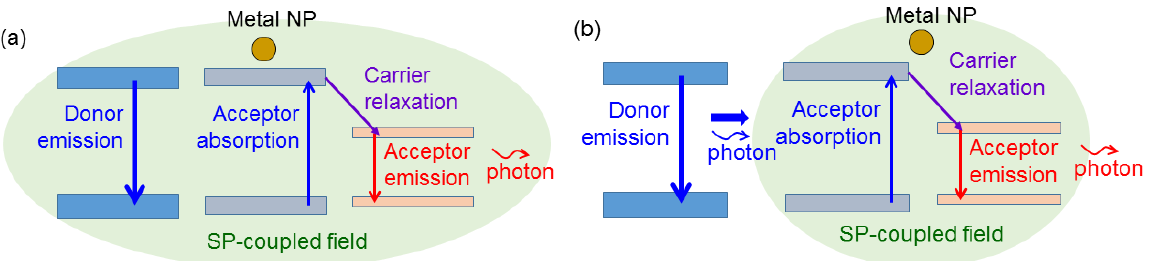
Figure 3. ( a ) Schematic illustration of a “three-body” SP-coupled down-conversion process when the SP resonance spectrum covers both emission wavelengths of the donor and acceptor while the donor, acceptor, and metal NP are close to each other. ( b ) Schematic illustration of an SP-coupled down-conversion process when the SP resonance spectrum covers both emission wavelengths of the donor and acceptor but the donor and acceptor are far apart.